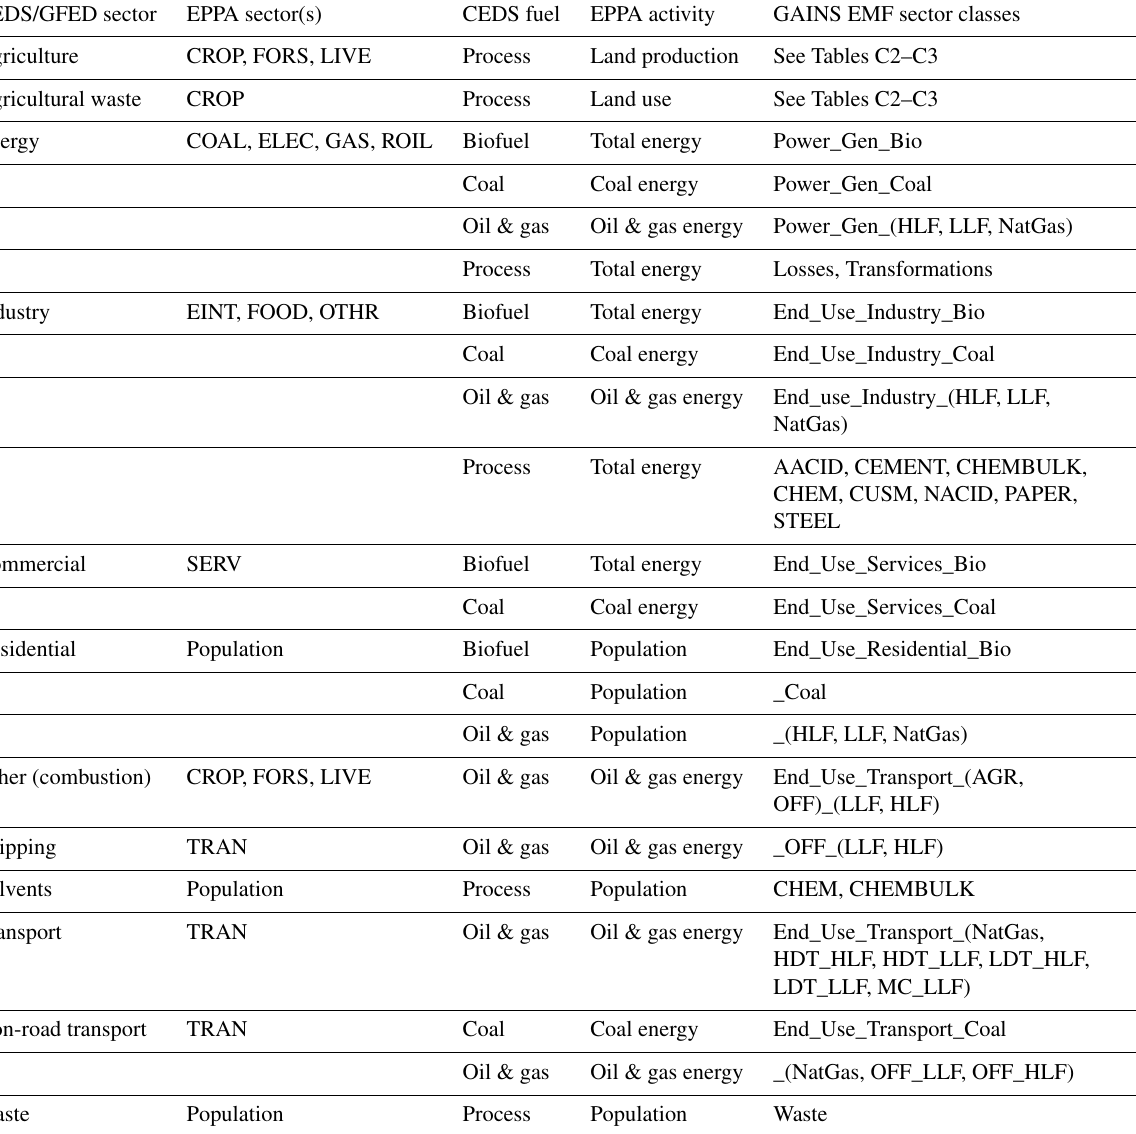
Table 1. Sectoral mapping and choice of scaling method for each inventory